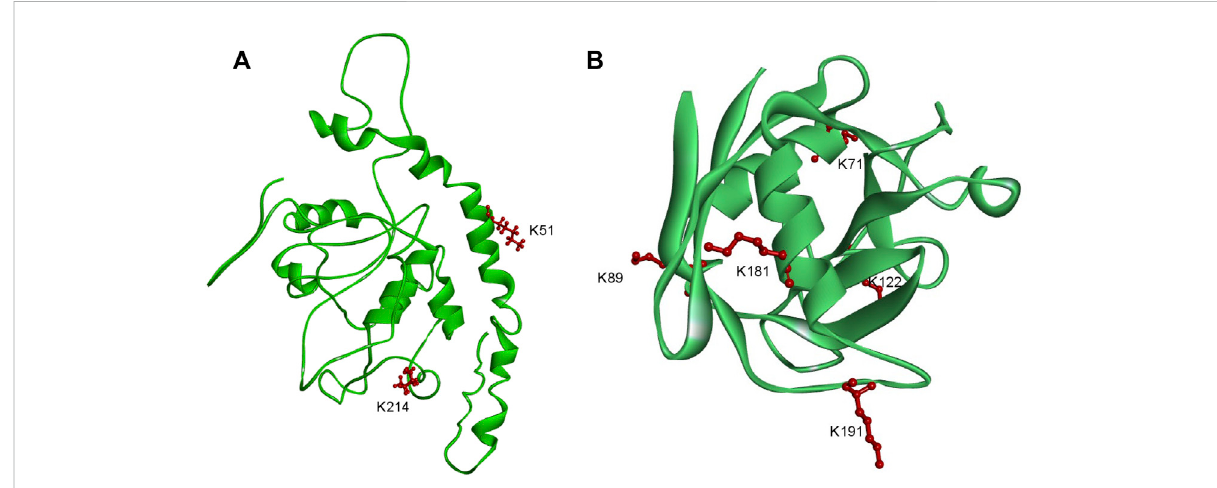
Schematic representation of the three-dimensional structures of two proteins in F. occidentalis involved in the transmission of TSWV. (A) EndoCP-GN. (B) Cyclophilin. Structure predicted by I-TASSER. Identi fi ed Klac sites were highlighted in